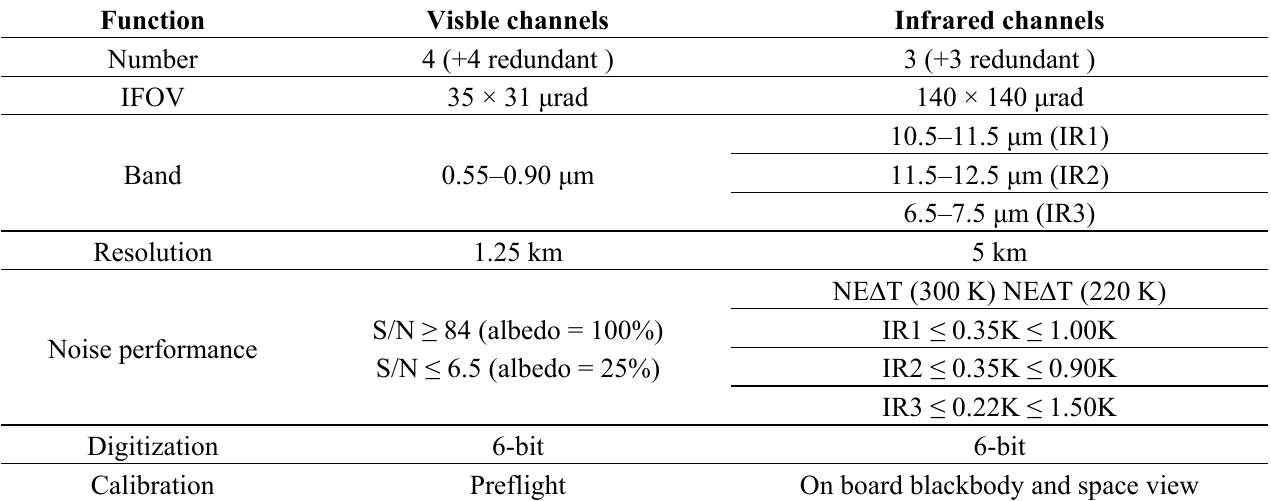
Table 1. Characteristics of the VISSR on